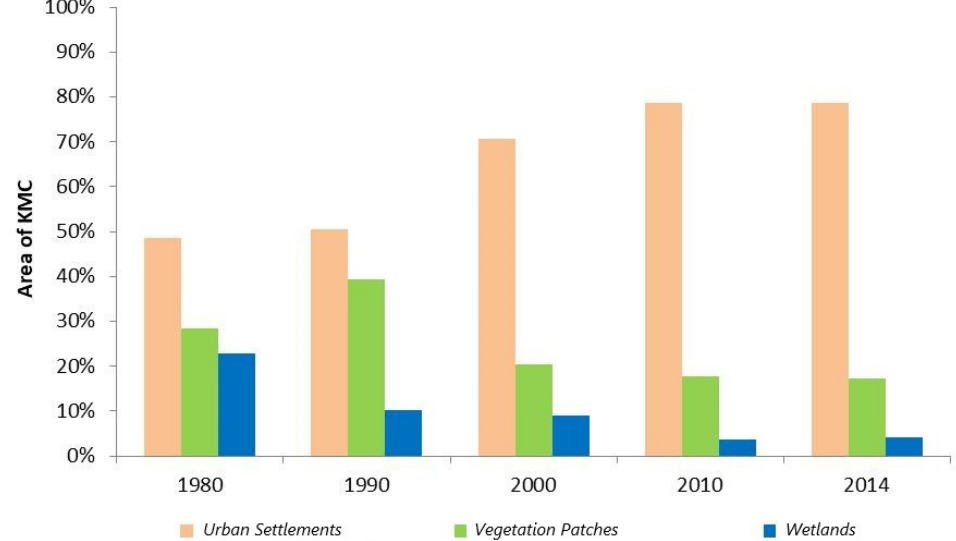
Figure 7. Relative distribution of major land use-land cover classes in Kolkata Municipal Corporation area (KMC) showed decade-wise since 1980. Major land use-land cover classes are differentiated into urban settlements , vegetation patches , and wetlands ; also compare Figures 4–6. (Data base courtesy: Satellite Image interpretation from Landsat (USGS) and LISS III series (ISRO, India) and the Govt. of West Bengal, India).